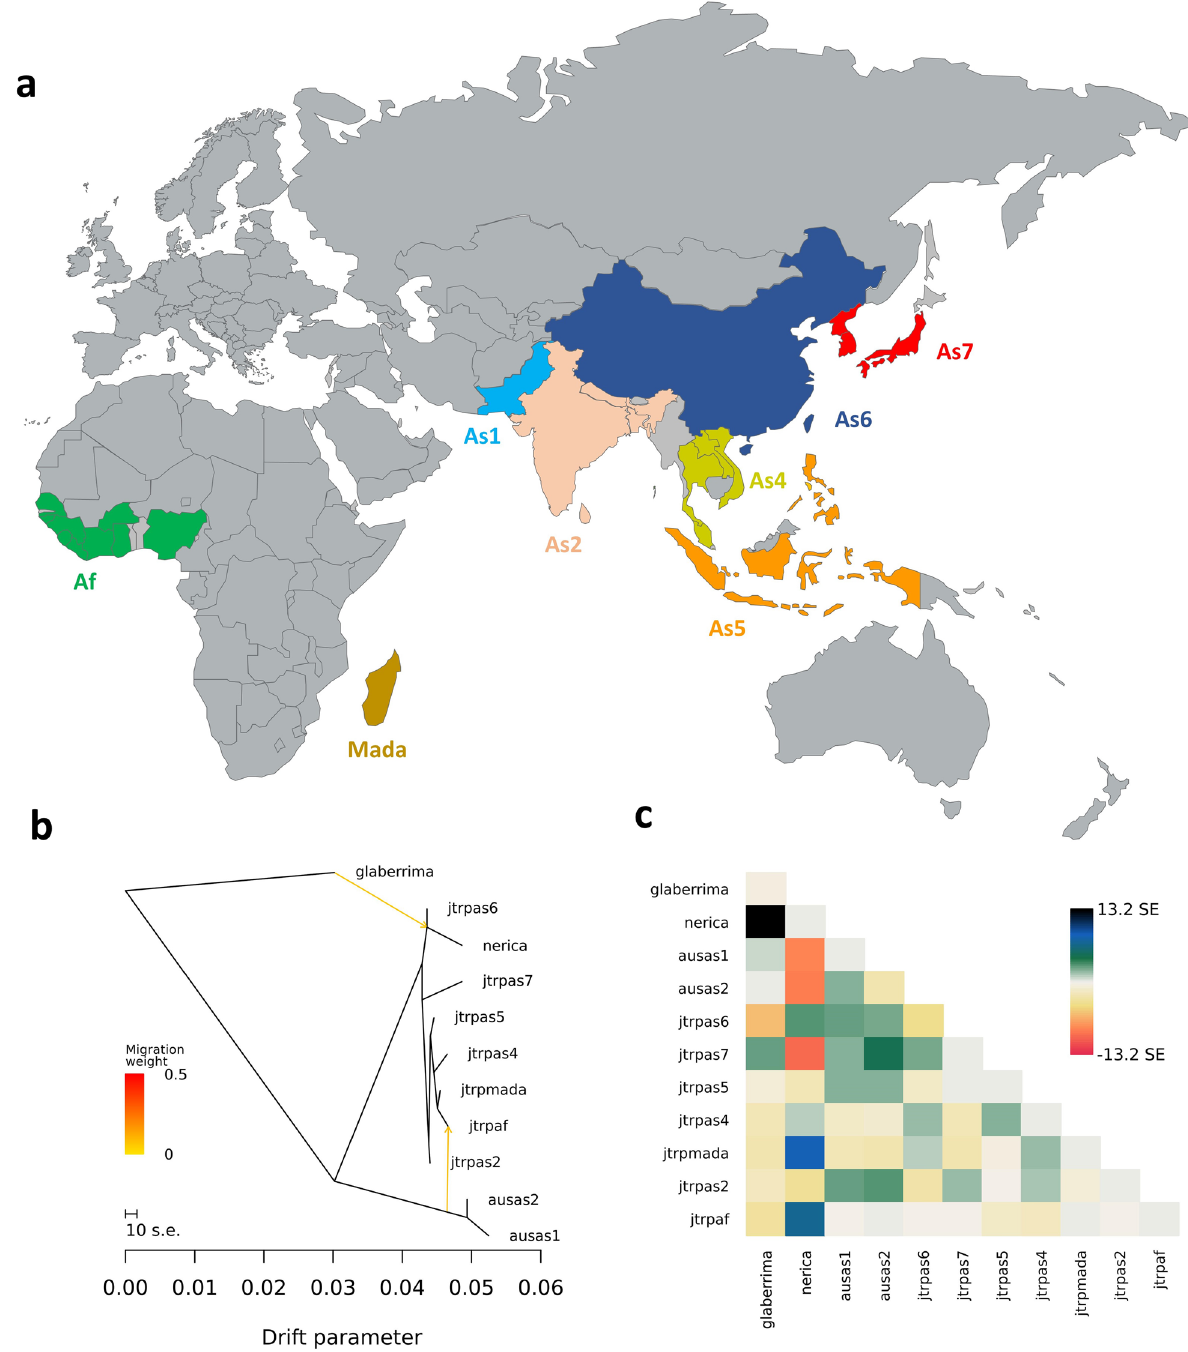
Fig. 5 TreeMix analysis and geographical distribution of tropical japonica and cAus accessions: a Different geographical groups considered in the Treemix analysis. In Africa, tropical japonica accessions from the West African highlands and Madagascar. In Asia, from West to East, the main groups we considered are shown. The clusters are defined by geographical zone. Each coloured country holds at least one accession from the dataset used for the Treemix analysis. b Maximum likelihood tree inferred by Treemix in chromosome 6 for the different genetic ( Oryza sativa japonica — Oryza sativa aus , Oryza glaberrima ) and geographical (from Africa and Asia) subgroups. The yellow arrows between the taxa indicate gene flow events simulated by the model. c Residuals from the model used to obtain the